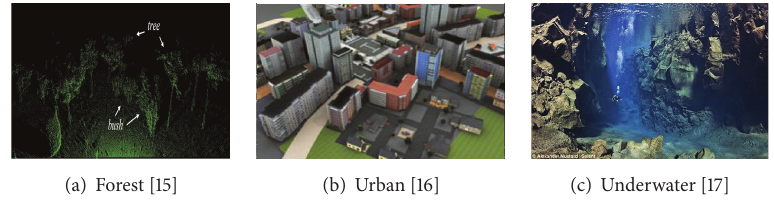
Figure 1: Examples of 3D complex